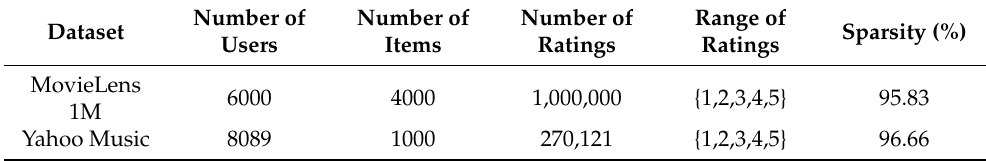
Table 1. Basic information on